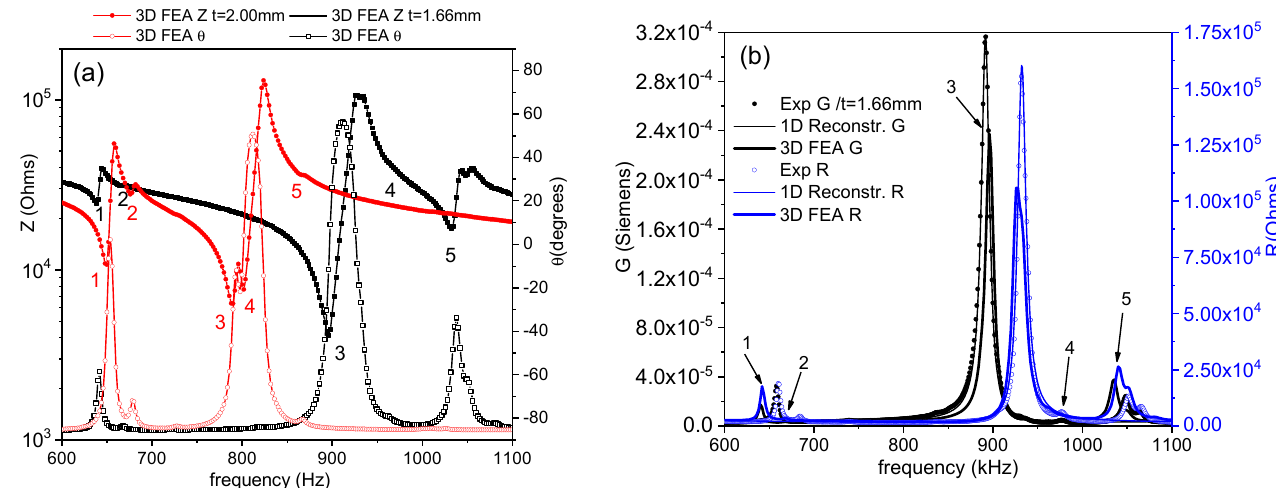
Figure 5. 3D FEA modeled shear resonance of non-standard, thickness-poled and longitudinally excited plates ( L ): ( a ) impedance spectra in ( Z , θ ) plots and ( b ) spectra in the equivalent ( R , G ) plots. In the ( Z , θ ) plots, the lines are only a “guide for the eye” in between the modeled points. In Figure ( a ), the spectra for plates with L = 7.49 mm, w= 7.45 mm, and with an initial t = 2 mm (red circles) and reduced t = 1.66 mm (black squares) are shown. Full symbols are used for the Z values and open symbols for the θ values. The corresponding experimental ( Z , θ ) plots are given in Figure 1a. In the equivalent ( R , G ) plots in Figure ( b ), the 3D modeled spectrum of the plate with a reduced t = 1.66 mm is shown as a black thick line for the G peak and blue thick line for the R peak. For comparison, the experimental spectrum and the 1D modeled one (the spectra reconstructed using the iterative method) are also shown in Figure ( b ). The symbols are the experimental data of G (closed black circles) and R (open blue circles), and the thin lines are the reconstructed peaks (1D model) (black line for G and blue line for R ). In Figure ( a , b ), the frequency interval covers the lateral modes (marked 1, 2, 4 and 5) on both sides of the fundamental shear mode (marked as 3).